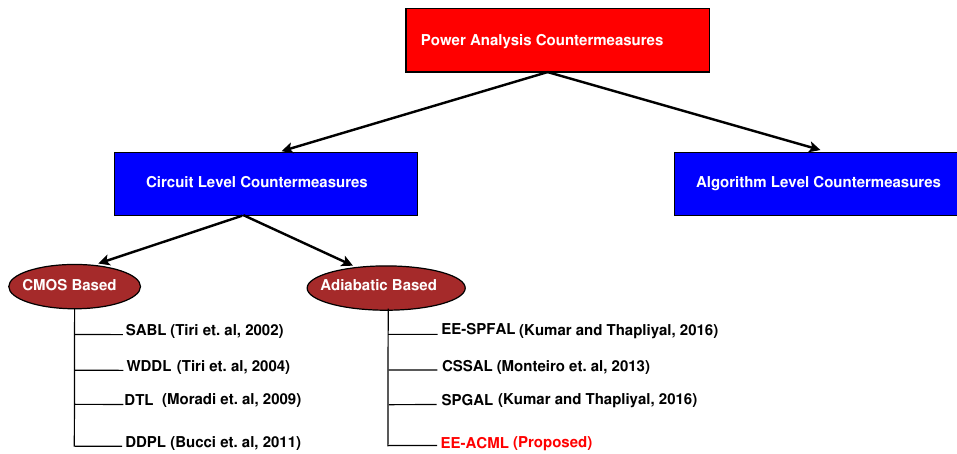
Figure 1. Correlation Power Analysis Countermeasures [7–9,11–14]